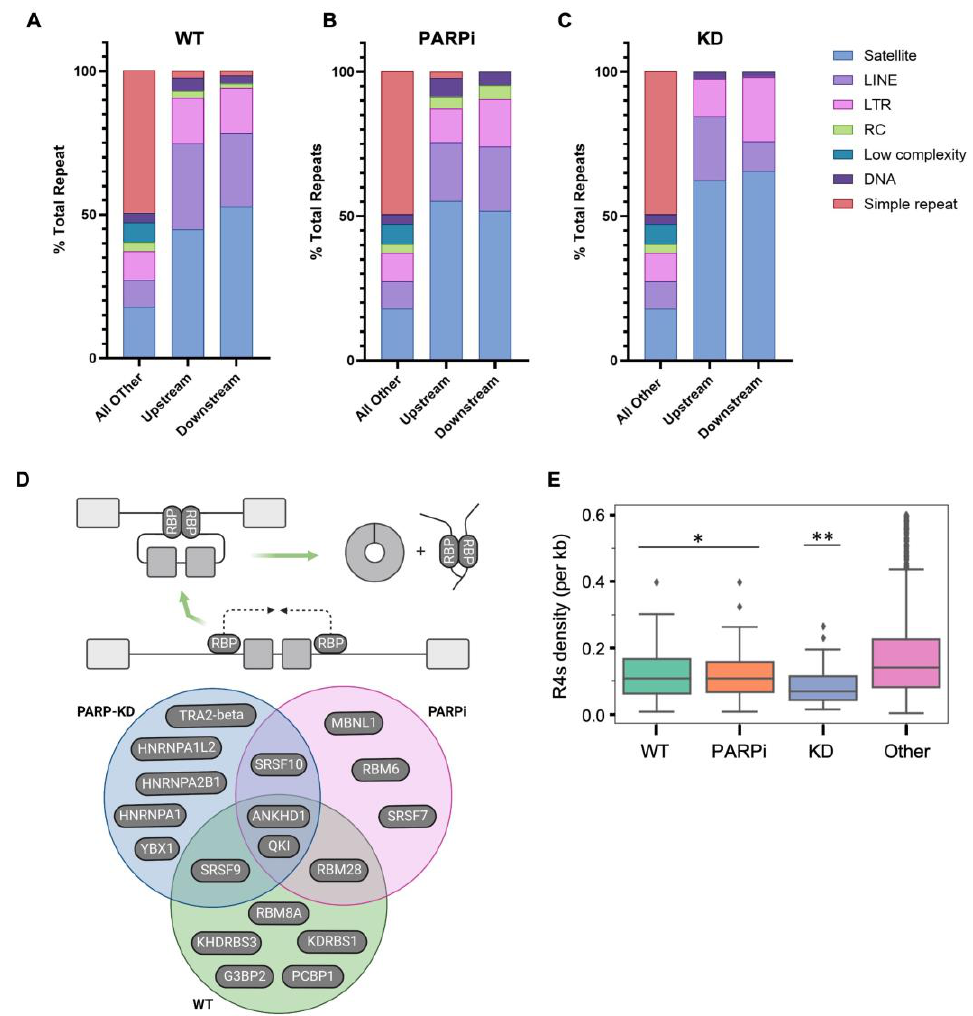
Figure 6. Flanking introns are differentially enriched for elements that regulate transcriptional space. The flanking introns of circRNA host genes were differentially enriched with repeat elements. Repeat elements enriched in wild type ( A ), PARPi ( B ), and PARP KD ( C ) upstream and downstream flanking introns compared to other Drosophila introns by type. ( D ) Venn diagram comparing RBP motifs significantly enriched ( p < 0.05) within both flanking introns of WT, PARPi, and PARP KD. The presence of unique sets of RBP motifs in flanking introns suggests PARP1 circRNAs are regulated by different pathways. ( E ) Box and whisker plot showing the density of R4 G-quadruplexes in WT, PARPi, and KD host genes compared to other Drosophila genes. The results (bar graph) are represented as mean plus SEM ( n ≥ 3; Student ’ s t -test, * p < 0.05, ** p < 0.05). The G-quadruplexes in the host genes and other Drosophila genes were identified using quadparser [26].